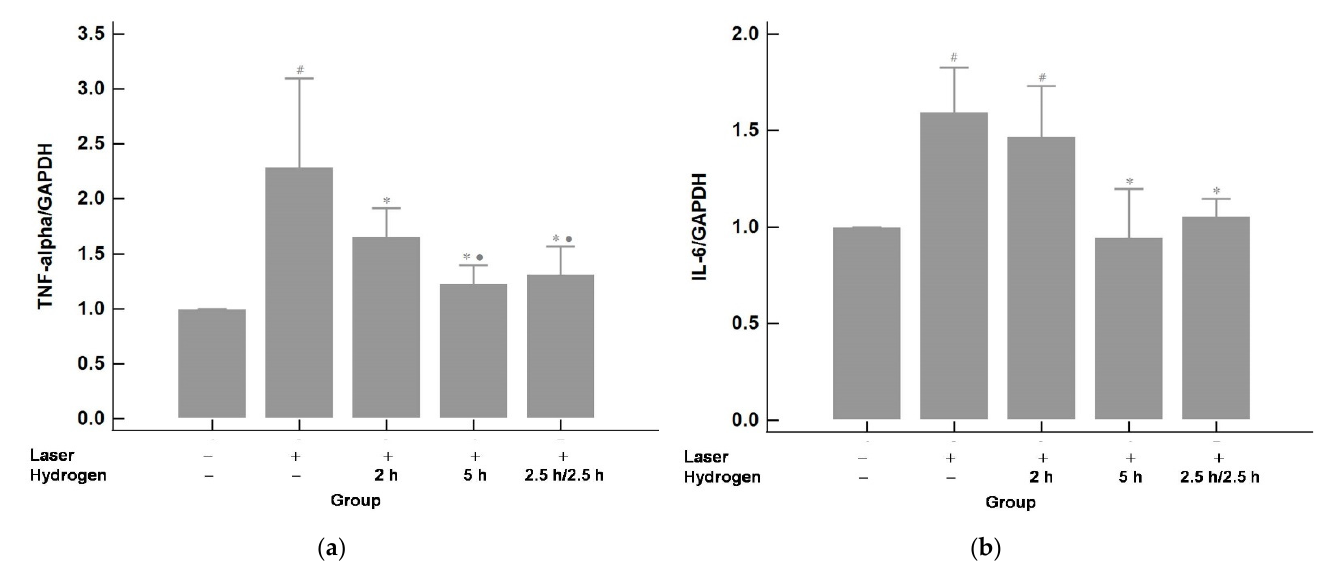
Figure 6. The mRNA expression of TNF- α ( a ) and IL-6 ( b ). The mRNA levels of TNF- α and IL-6 were upregulated after laser photocoagulation compared with those of the control (no laser or hydrogen inhalation). The upregulation could be suppressed by hydrogen inhalation. The effects of the 2.5 h/2.5 h and 5 h groups were similar and were more effective than the 2 h group. # p < 0.05 compared with the control (laser − / hydrogen − ) group; * p < 0.05 compared with the laser+ / hydrogen − group; • p < 0.05 compared with the laser+ / hydrogen 2 h group.